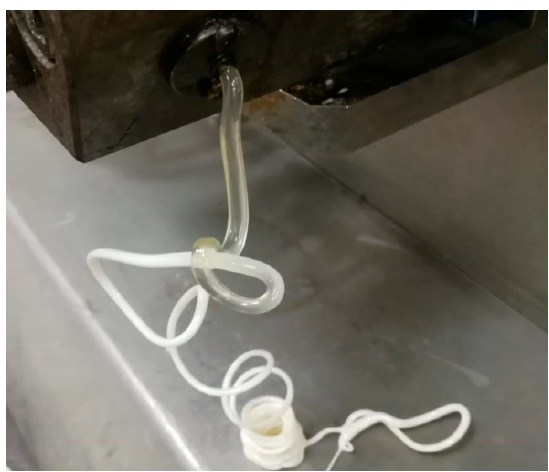
Figure 13 . A 60/40 PBT/PET melt emerging from the die is transparent, indicating that the components are either miscible in the melt, or the constituents are in nano domains with similar refractive indices. On cooling, whitening occurs due to crystallisation.